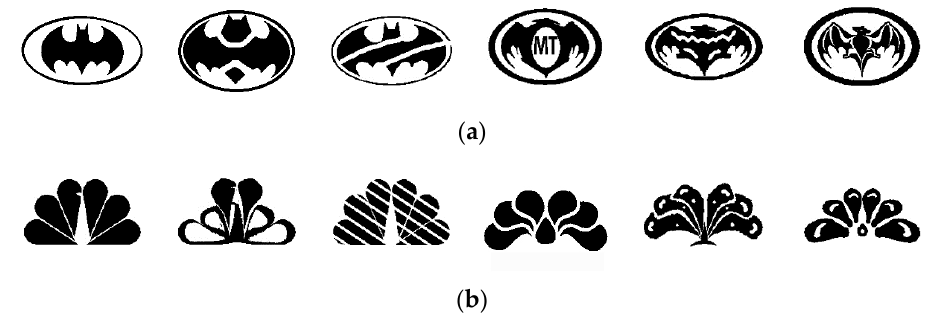
Figure 14. Various images within ( a ) Class 2 and ( b ) Class 5.